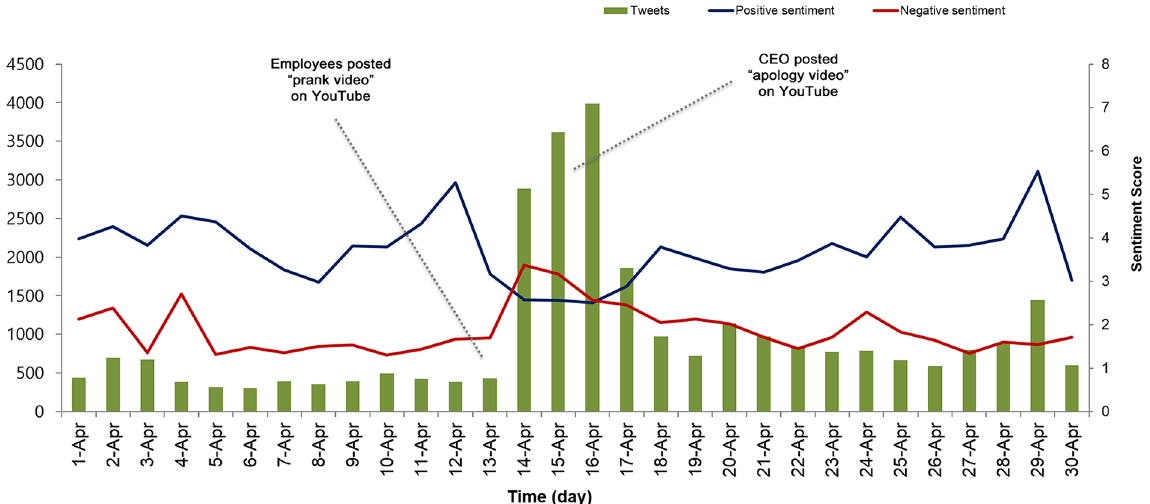
Fig 1. Temporal evolution of the number of tweets per day (green) during April 2009, and the positive (blue) and negative (red) sentiment scores measured by Linguistic Inquiry and Word Count. The Domino's Pizza crisis started on 13th and the public apology by the Domino Pizza CEO was delivered on